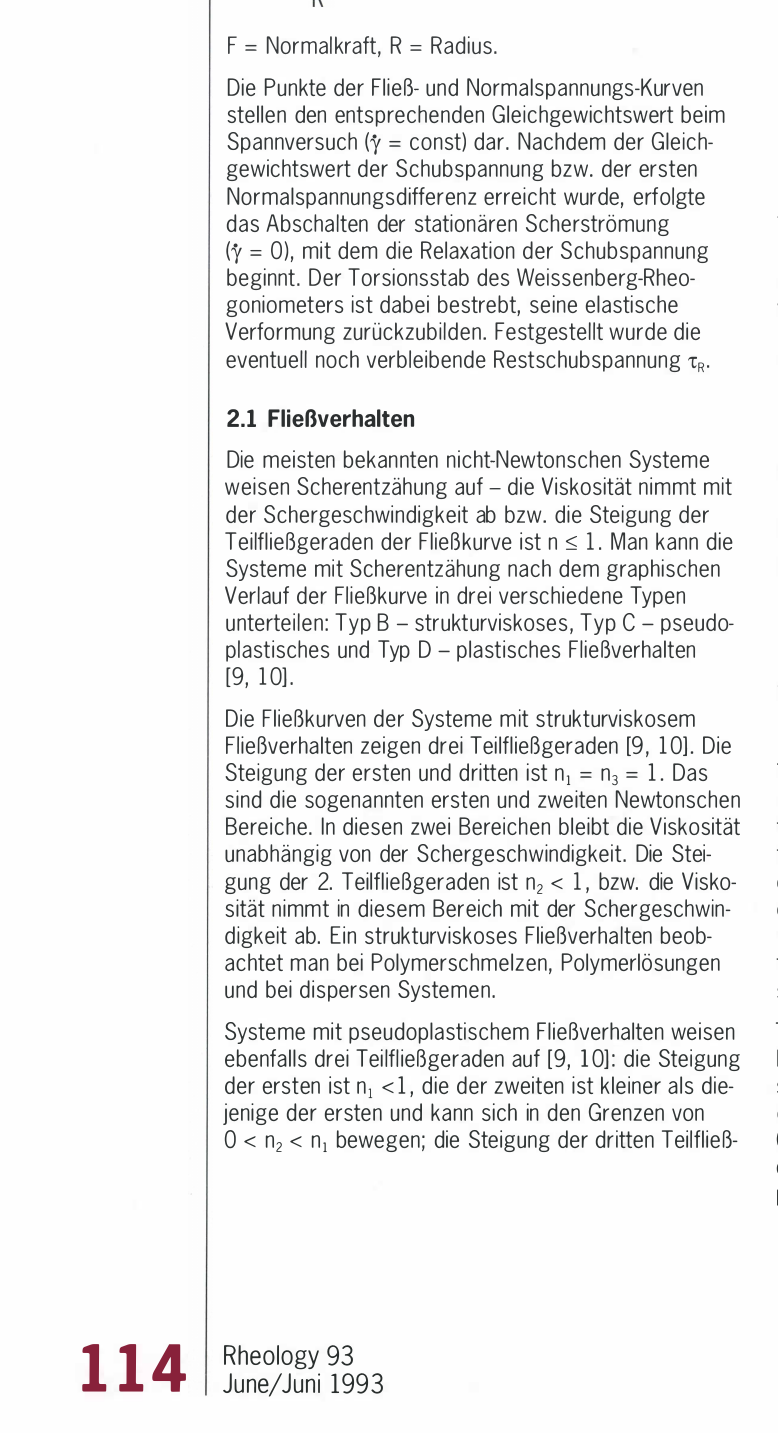
Fig. 1: Flow curves for silicone fluid M 20'000 with different Cab-o-sil